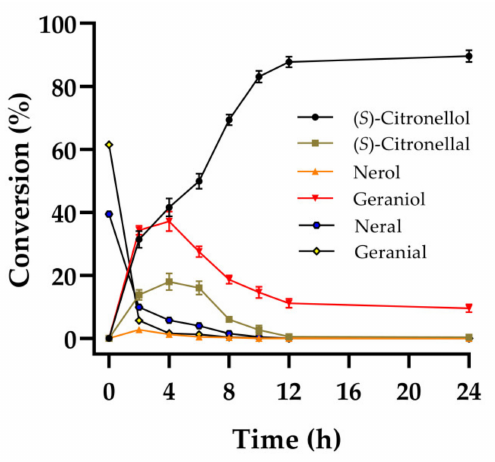
Figure 6. Time courses of the reduction of 400 mM ( E / Z )-citral to (S)-citronellol. The reaction mixture (10 mL) contained 100 g/L wet cells co-expressing three enzymes, 400 mM ( E / Z )-citral, 1200 mM glucose, 0.4 mM NADP + , 4% ( v / v ) isopropanol and 50 mM PIPES buffer (pH 6.5). Constant pH was kept through the titration of 1 M NaOH. The reactions were conducted at 30 ◦ C and 400 rpm for 24 h. Standard deviations are indicated in the diagram ( n =